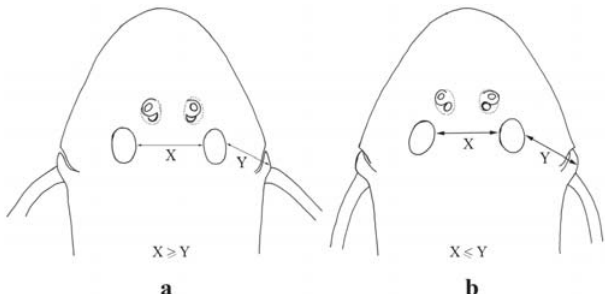
Fig. 6. Schematic drawing of dorsal view of head of Lamontichthys llanero (a) and L . filamentosus (b). The “x” indicates interorbital distance and “y” indicates distance from orbit to exposed border of cleithrum.